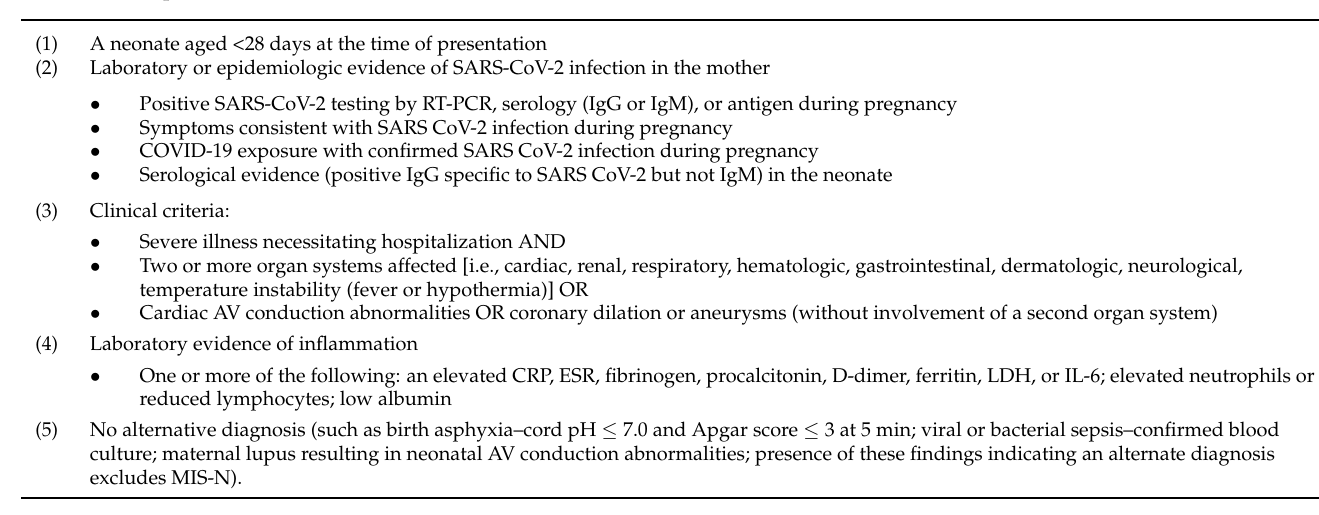
Figure 1. Various presentations of SARS-CoV-2 infection and its sequences in the neonatal period. Red colored subjects with a ‘+’ sign indicate COVID-19 positive patients. Pregnant mother A has COVID-19 and her baby is negative at birth but contracts late-onset COVID-19 due to transmission from the mother. Pregnant mother B has no COVID-19 but her neonate develops late-onset neonatal infection due to exposure to a family member 2–4 weeks after birth. Pregnant mother C is COVID-19 positive during the perinatal period and transmits the virus to her offspring during birth leading to early-onset infection in the neonate. This baby can potentially develop MIS-C 2–4 weeks later (a rare occurrence) [16]. Pregnant mother D has COVID-19 during pregnancy but the neonate remains healthy. Pregnant mother E has COVID-19 disease or exposure to SARS-COV-2 during pregnancy and the baby develops multisystem inflammation secondary to passive transfer of antibodies leading to MIS-N (multisystem inflammatory syndrome in neonates) [14]. Table 1. Proposed inclusion criteria for neonatal multisystem inflammatory syndrome (MIS-N) secondary to maternal SARS CoV-2 exposure or infection.